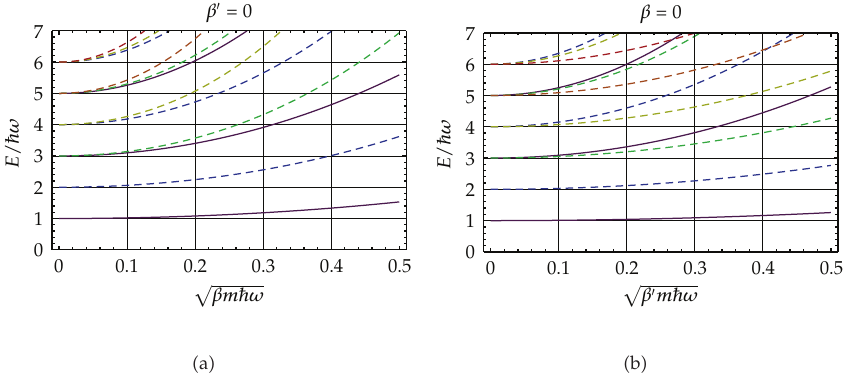
Figure 2: The energy levels of the 2D isotropic harmonic oscillator for the cases β (cid:3) (cid:4) 0 (cid:5) left (cid:6) and β (cid:4) 0 (cid:5) right (cid:6) . The purple solid lines indicate s -wave states which are singlets. The dashed lines are doublets with the color indicating that (cid:2) (cid:4) 1 (cid:5) blue (cid:6) , (cid:2) (cid:4) 2 (cid:5) green (cid:6) , (cid:2) (cid:4) 3 (cid:5) yellow (cid:6) , (cid:2) (cid:4) 4 (cid:5) orange (cid:6) , and (cid:2) (cid:4) 5 (cid:5) red (cid:6) .